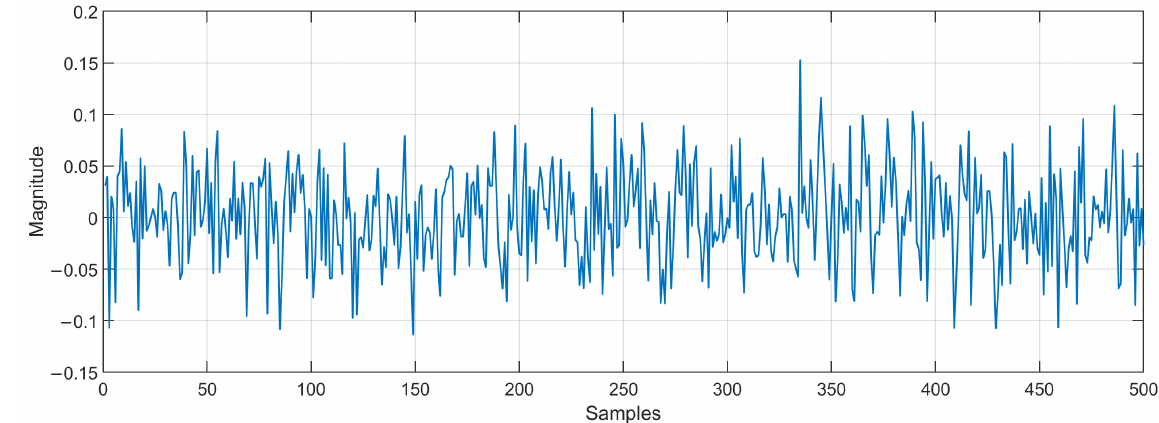
Figure 4. Impulse response of the acoustic echo